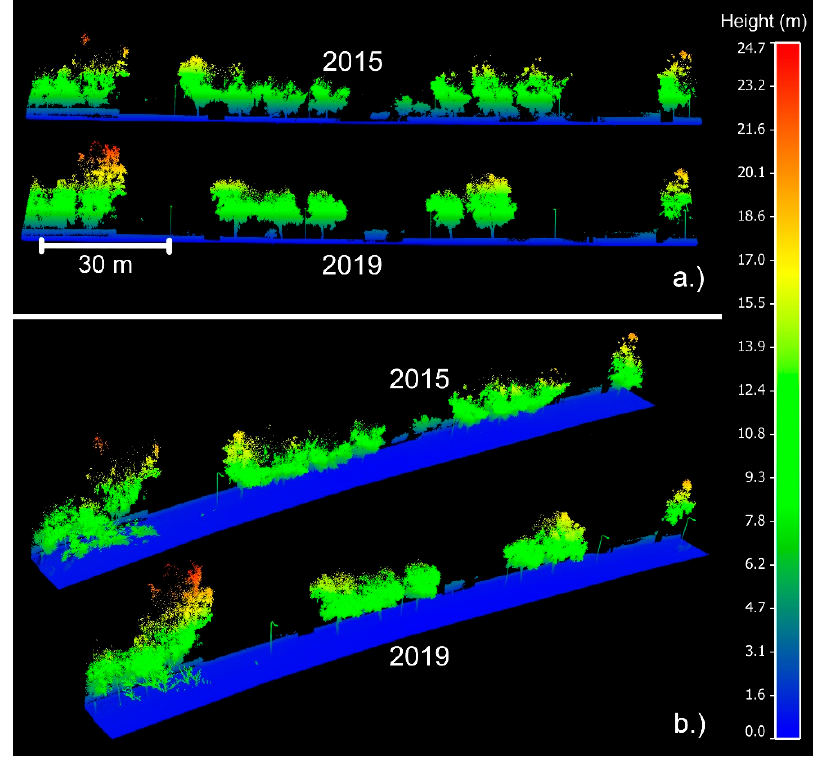
Figure 3. Visual assessment of the roadside vegetation. From the side ( a. ) and diagonally above ( b. ). Pseudo-coloured maps of the height (m) or the z-axis in local coordinates.